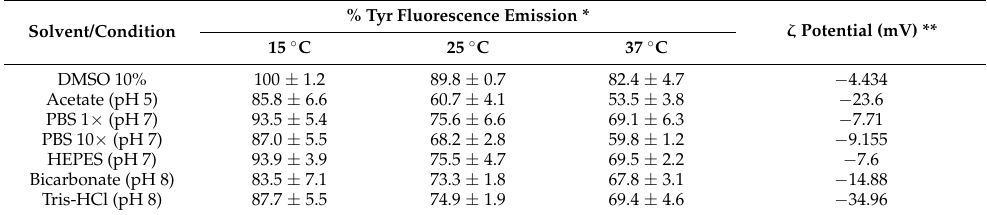
Table 1. Percentage of Tyr fluorescence emission and ζ potential values of ACE2 peptide mimic when exposed to different environmental conditions.